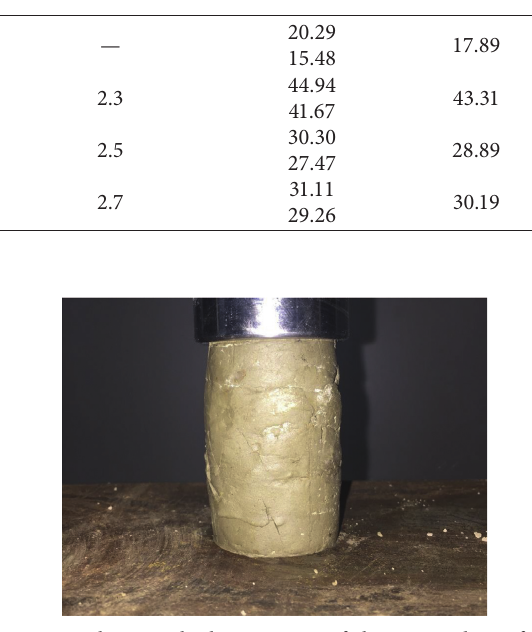
Table 5: Unconfined compressive strength of soft clay specimens (curing time 28 d). Nutrient concentration Specimen no.